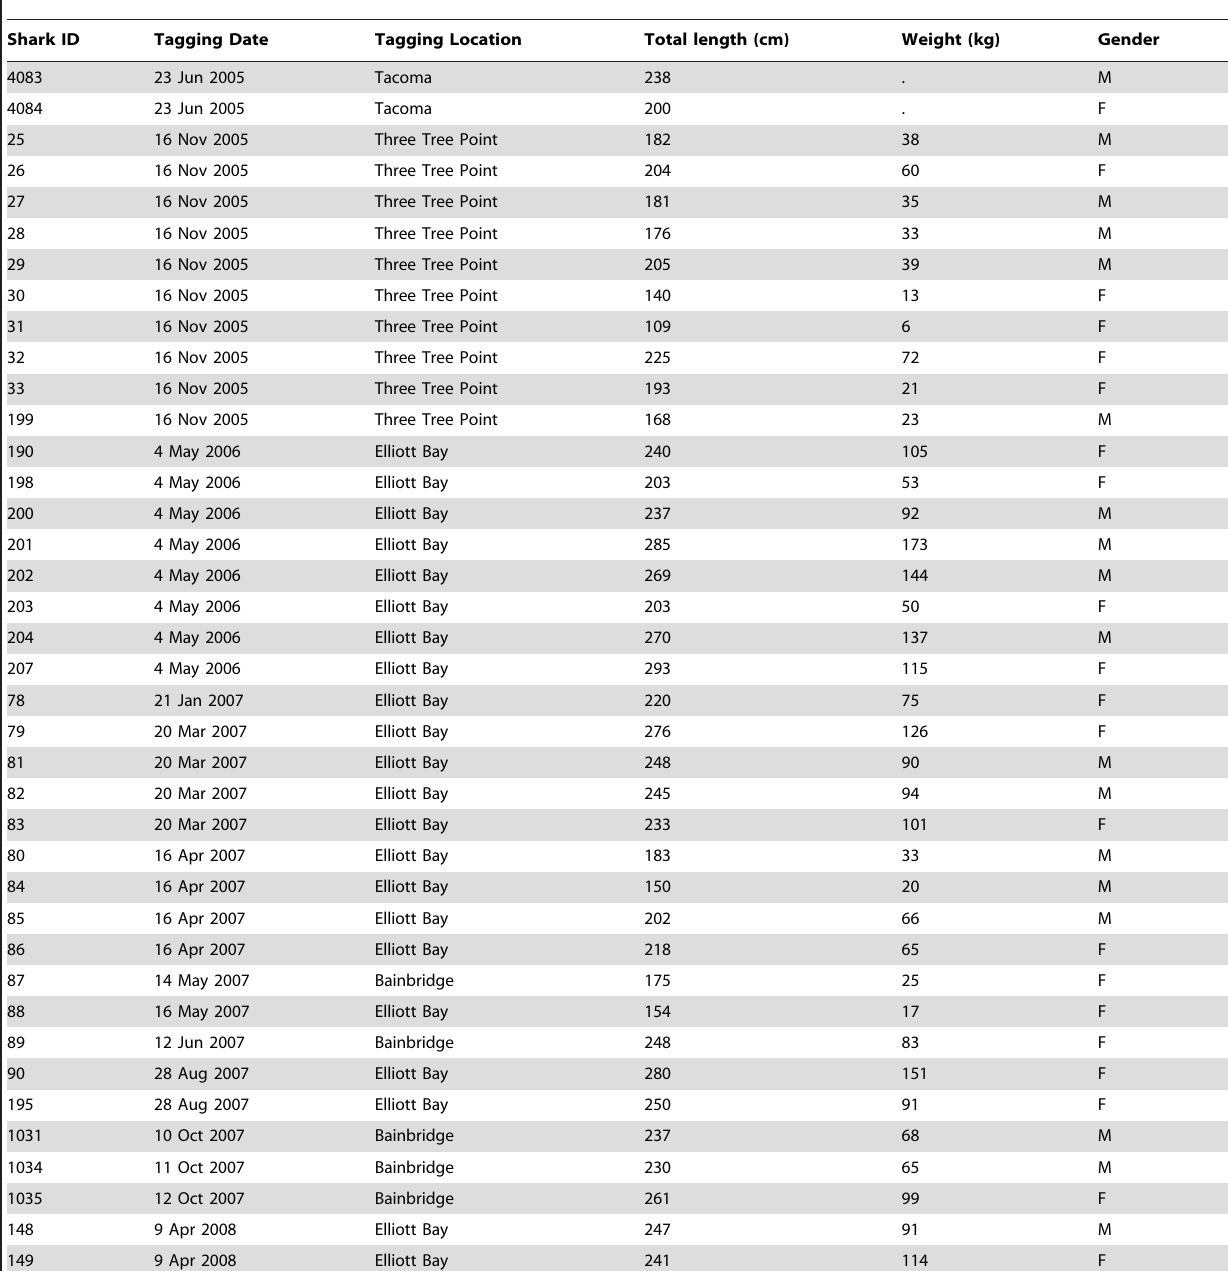
Table 1. Biological data of 39 sixgill sharks tagged with acoustic transmitters from 2005–2008 in Puget Sound, WA,